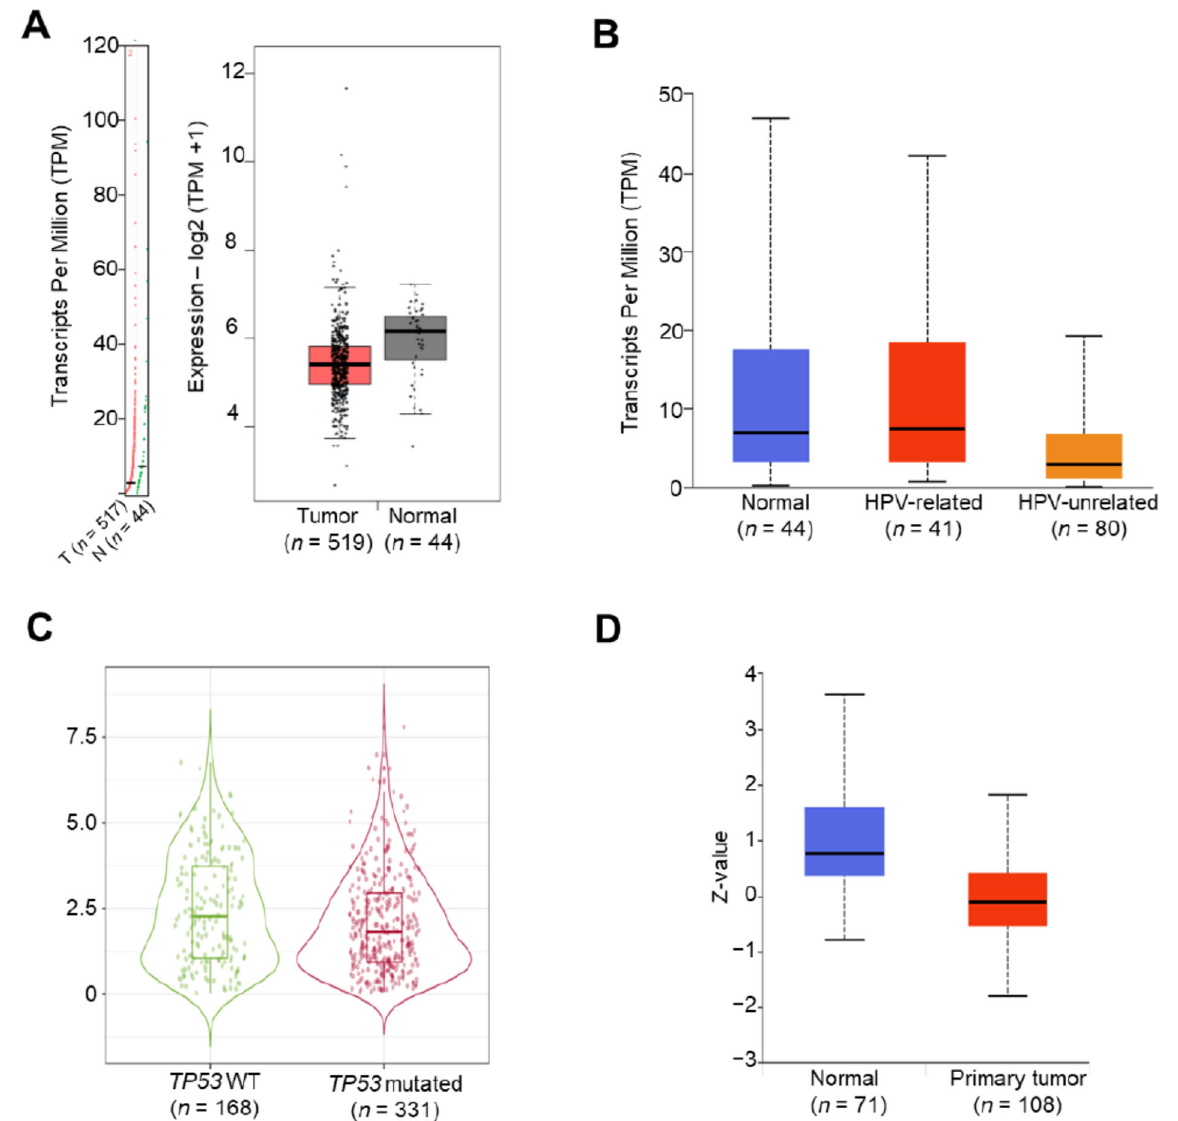
Figure 1. The FCGBP levels in head and neck squamous cell carcinoma (HNSC) patients. ( A ) Gene Expression Profiling Interactive Analysis 2 (GEPIA2) illustrated the differential expression levels of the FCGBP transcript in tumor and adjacent normal tissues based on HNSC dataset. ( B ) UALCAN showed the FCGBP levels in normal tissues, HPV-related ( n = 41) and HPV-unrelated ( n = 80) HNSC. ( C ) TIMER 2.0 identified the FCGBP levels in HNSC with TP53 wild-type (WT) and mutated, respectively. ( D ) The protein level of FCGBP in cancer ( n = 108) and non-cancerous tissues ( n = 71) were shown, based on Clinical Proteomic Tumor Analysis Consortium (CPTAC).